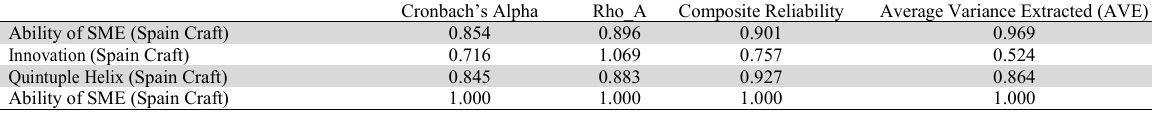
Fig. 7. Fit model Spain craft sub sector Reliability and validity indicators for fit model